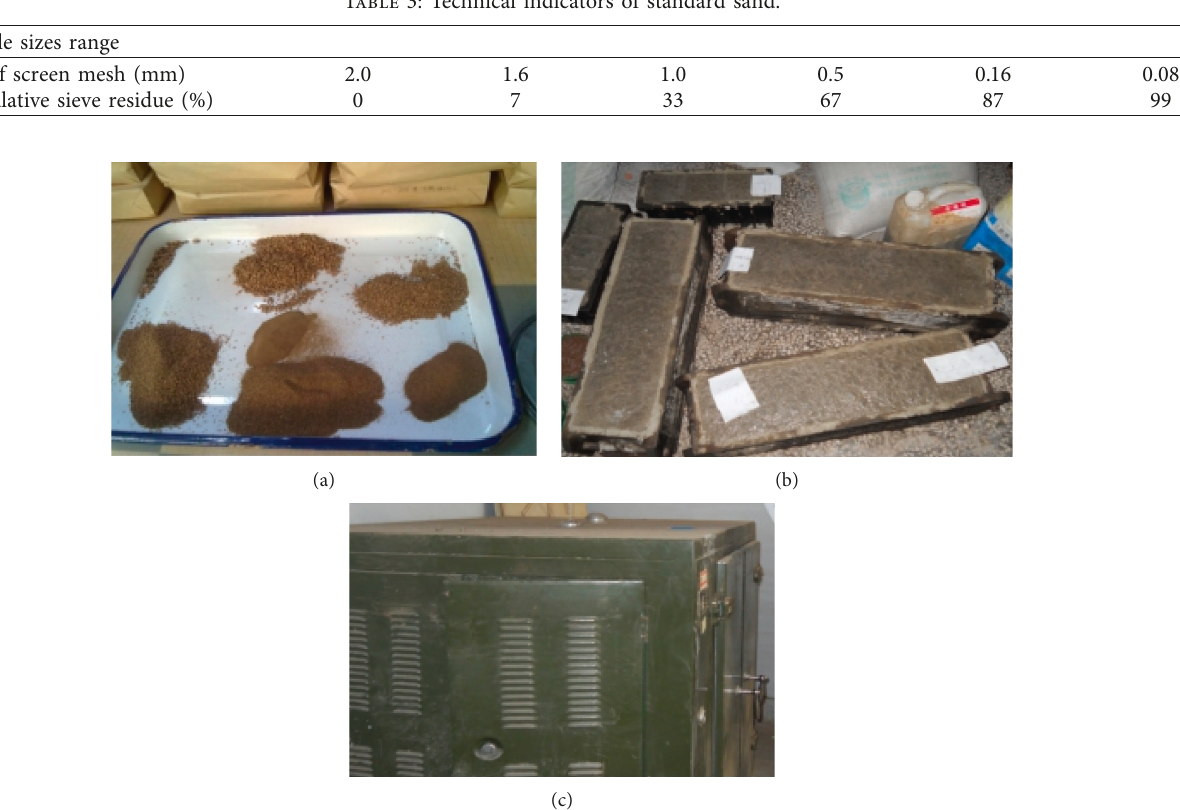
Table 3: Technical indicators of standard sand.